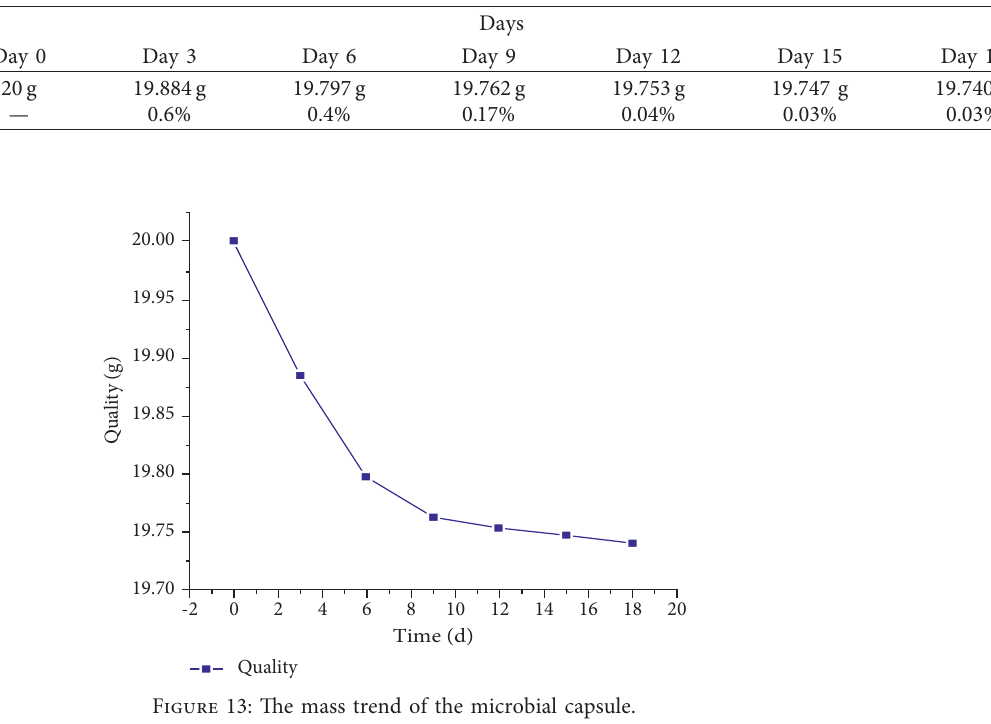
Figure 12: The waterproofness of microbial capsule. Table 6: The measurement of stability of microbial capsule.